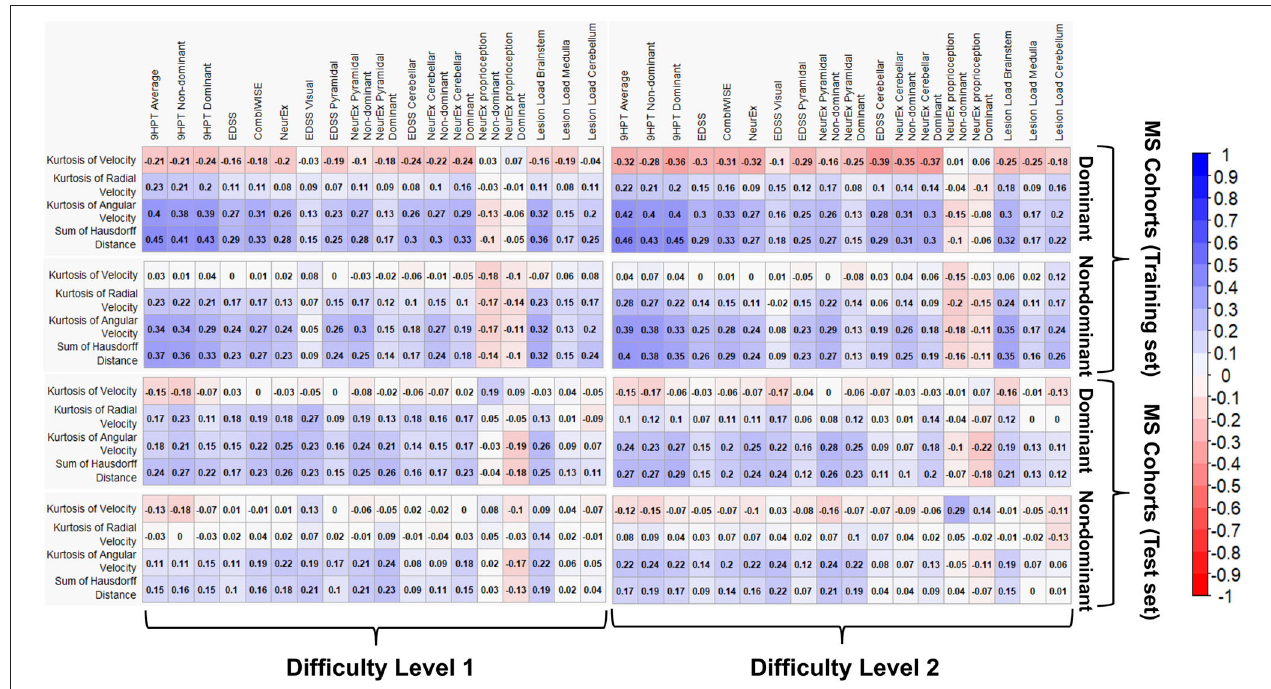
FIGURE 9 | Spearman Rho correlation matrix between the statistically significant clinical disability and the top four most significant spiral-derived features based on FC at the difficulty level 1 and 2. The number indicates the Spearman correlation coefficient. Red is a negative correlation while blue stands for positive correlation. The white color indicates correlations that are not statistically significant at BH adjusted p -value of 0.05 (FC indicates Fold-Change, while BH denotes